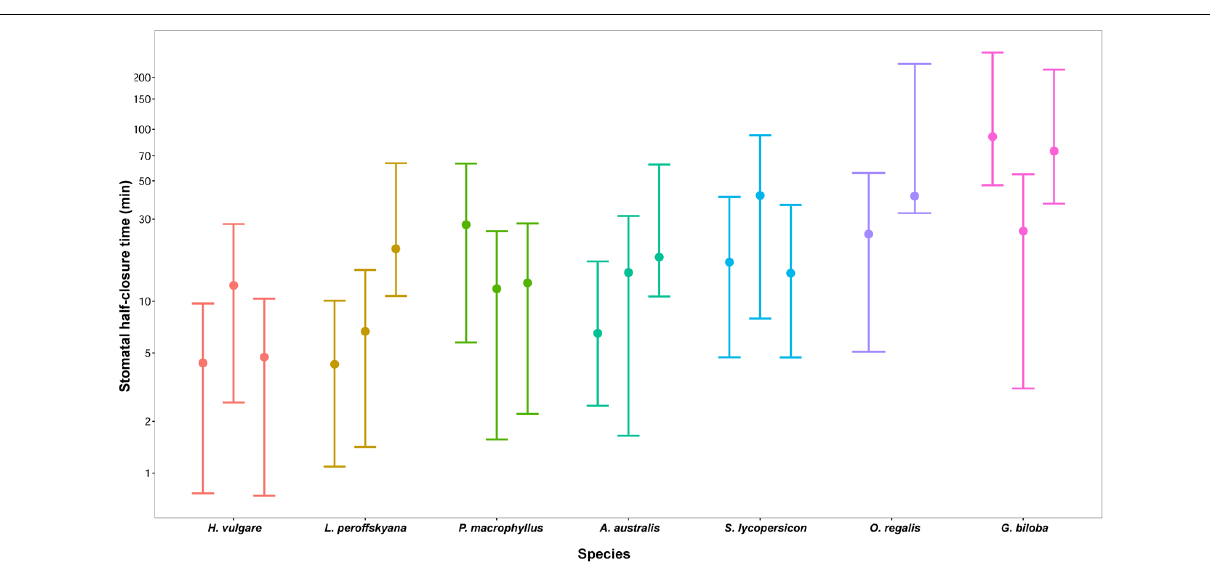
FIGURE 2 | log e (median stomatal half-closure time) of seven species. H. vulgare = Hordeum vulgare (graminaceous angiosperm); L. peroffskyana = Lepidozamia peroffskyana (cycad); P. macrophyllus = Podocarpus macrophyllus (conifer); A. australis = Agathis australis (conifer); S. lycopersicon = Solanum lycopersicon (angiosperm); O. regalis = Osmunda regalis (fern); G. biloba = Ginkgo biloba (ginkgophyte). The fastest species to close stomata in response to darkness was Hordeum vulgare ; the slowest was Ginkgo biloba